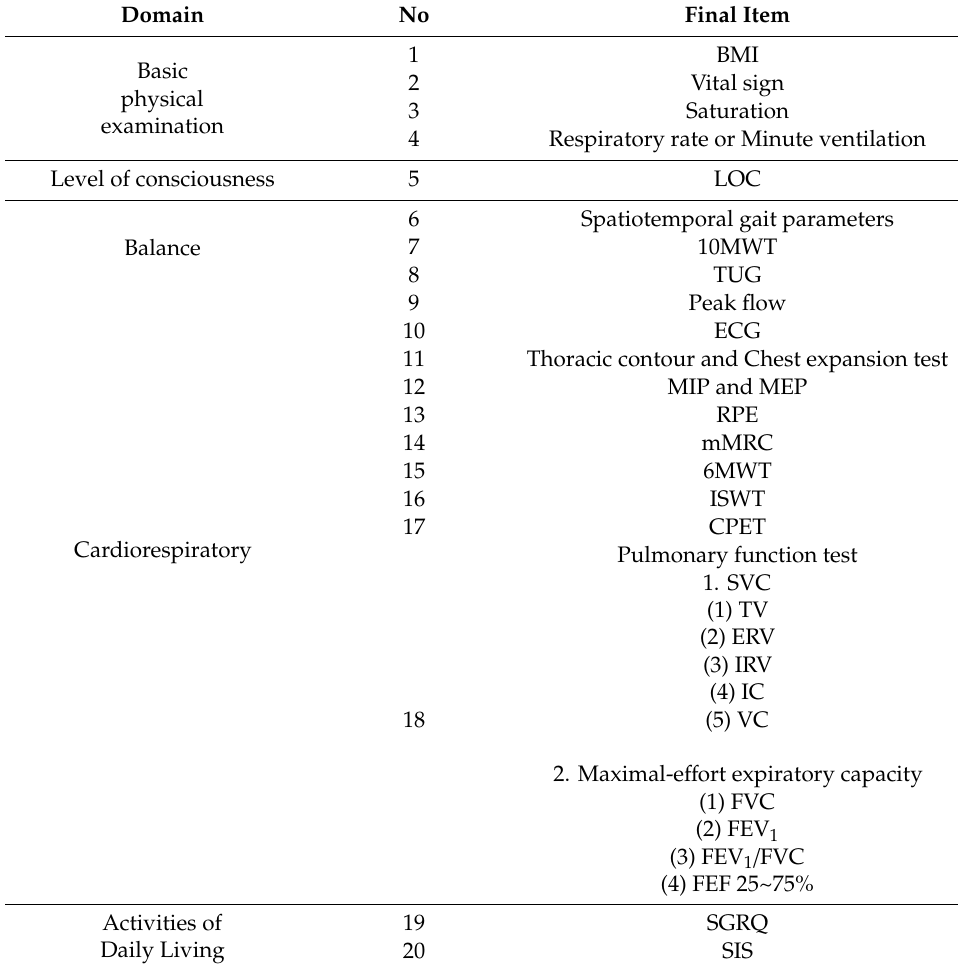
Table 13. Cardiorespiratory physiotherapy final evaluation items for stroke